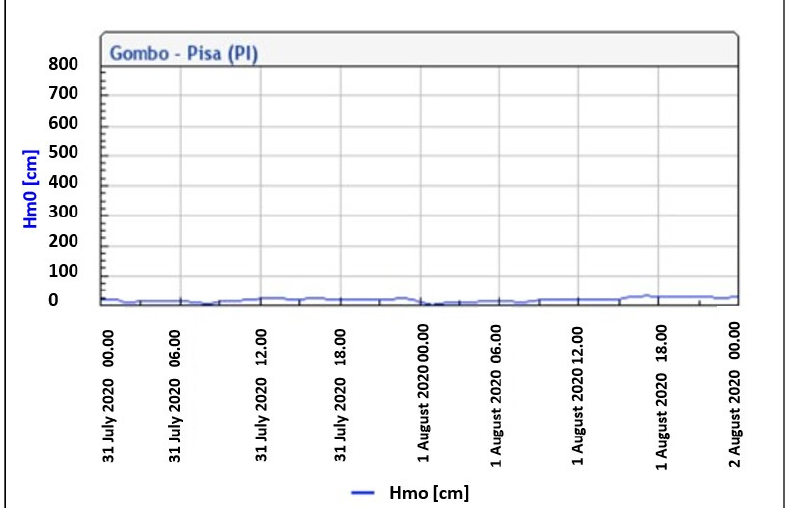
Figure 17. Wave height recorded by “Gombo”, the wave buoy of the Functional Center of the Tuscany Region.